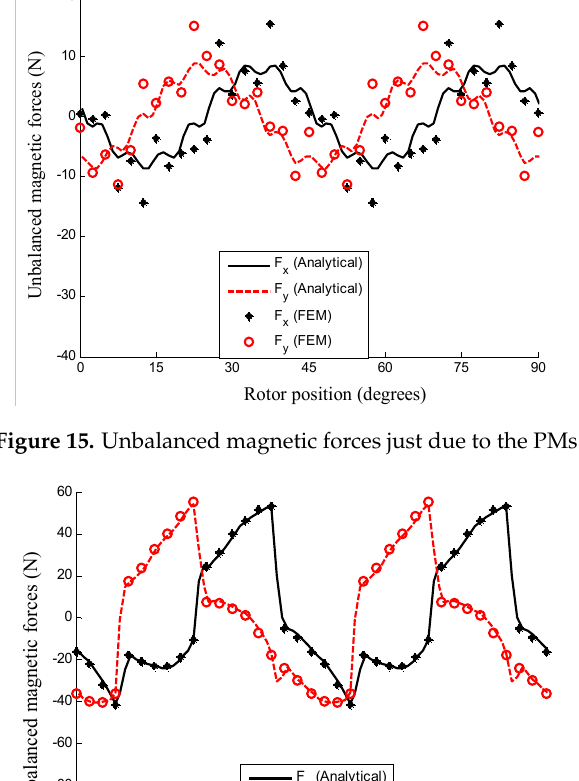
Figure 16. Unbalanced magnetic forces just due to the armature reaction.